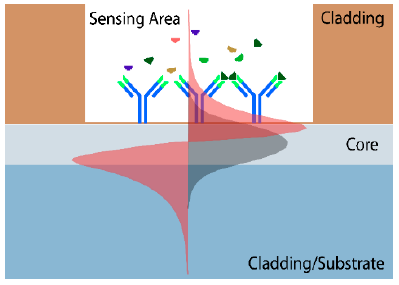
Figure 1. Evanescent wave detection principle.